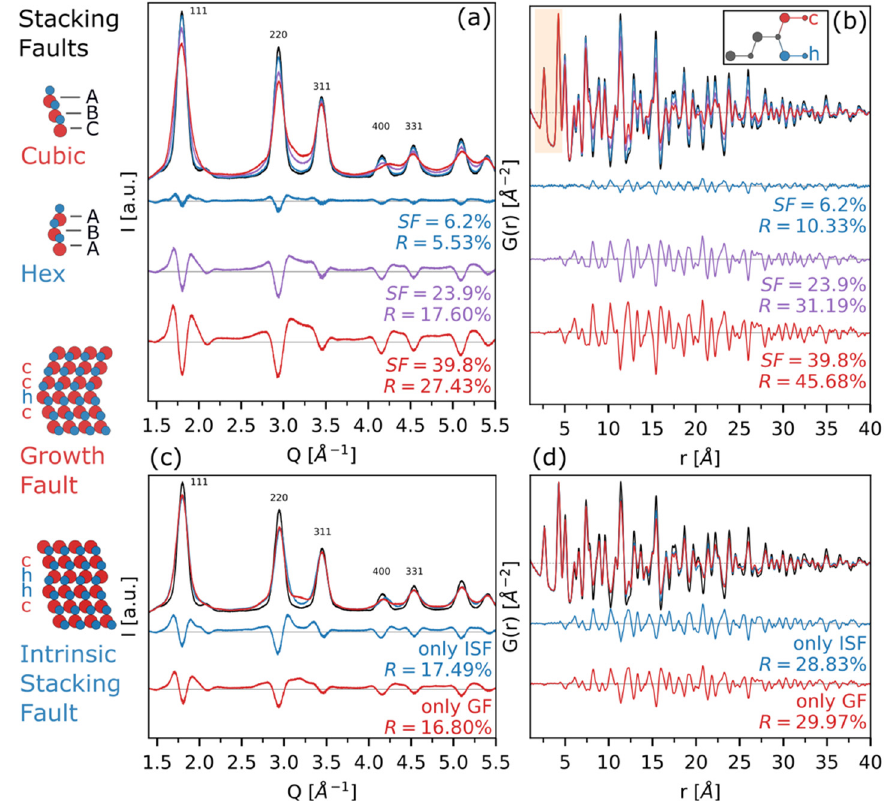
Figure 6. ( a ) DSE simulations of different SF% (6.2, 23.9, and 39.8) introduced in a CdSe population of prismatic nanocrystals with average sizes L a = L b = 4.7 nm ( σ / L a = 6.9%) and L c = 3.5 nm ( σ / L c = 10.7%). ( b ) Corresponding G ( r ), with the features in the low- r region assigned to interlayer interatomic distances (scheme in the inset), and highlighted with a shaded area. Effects on DSE peak width and position, due to growth (GF, α = 0.57, β = 1.00, γ = 1.00, δ = 1.00), and intrinsic SF (ISF, α = 0.85, β = 0.85, γ = 1.00, δ = 0.00) ( c ), and their corresponding sine-Fourier transform ( d ), at a constant SF% ( ∼ 23%). Difference traces and agreement factors against the unfaulted model are provided for all simulations. Further details on the SFs parameters used for these simulations are given in Table S3.